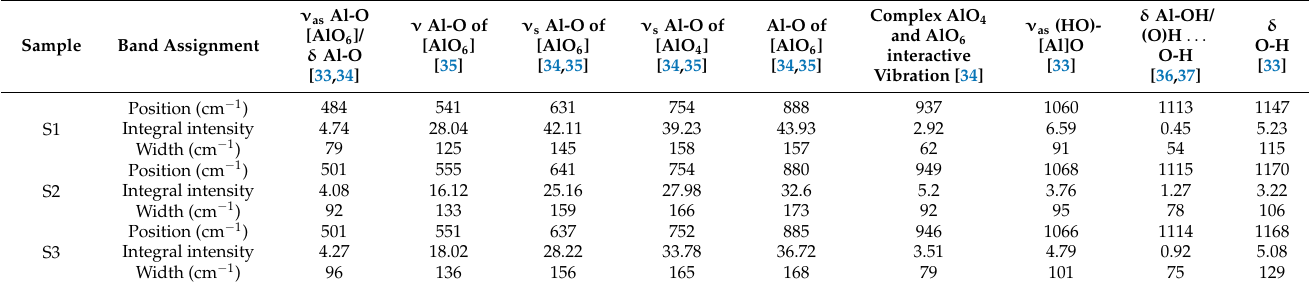
Table 4. Positions and assignments of the bands from spectra deconvolution for samples S1, S2, S3.